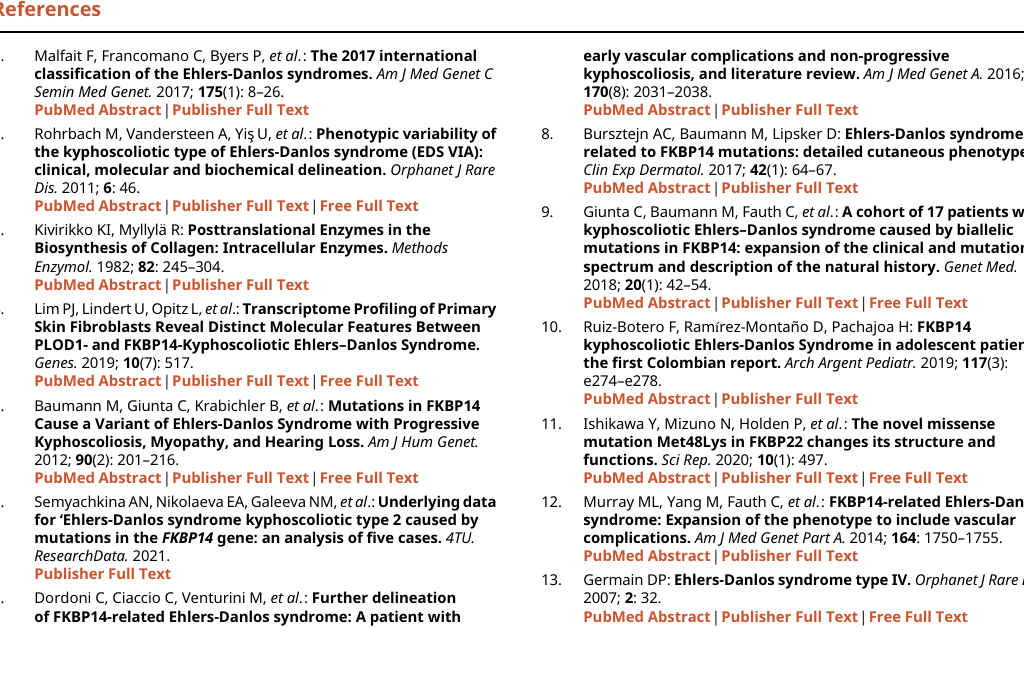
(cid:129) Picture file 2. Electropherogram of the exon 3 of the FKBP14 gene. A homozygous c.362dupC pathogenic variant in exon 3 of the FKBP14 gene. (cid:129) Data file 1.